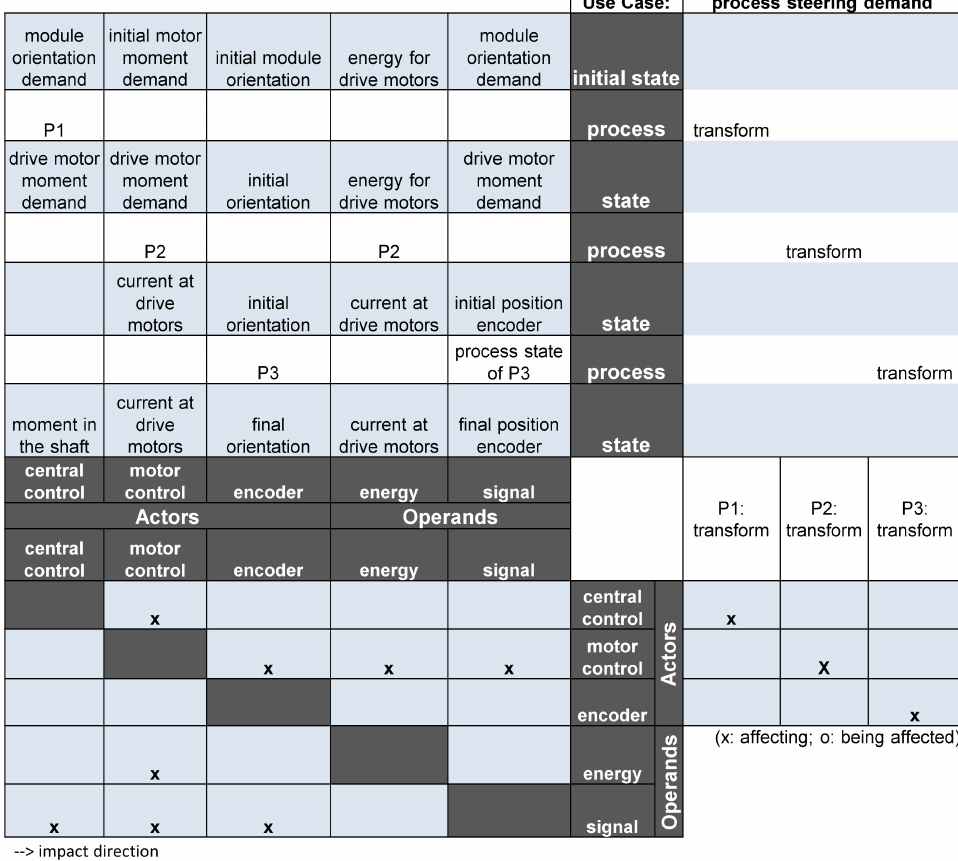
Figure 3. Functions of an AGV modelled in the IFM